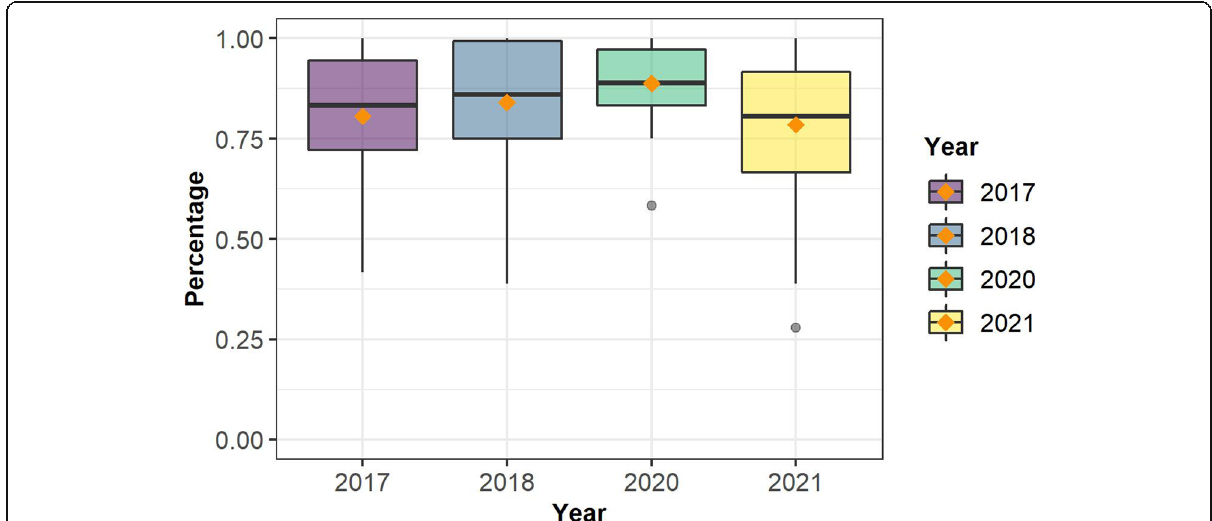
Fig. 3 Mid Semester Total Evaluation scores (shown as percentages)